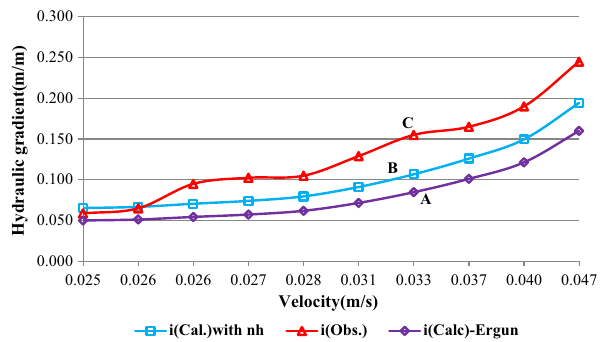
Fig. 10 Comparing plots of hydraulic gradient versus velocity for CGM1 series. Result is after 1200 s of run start. Curve “A” shows variations of ( i ) versus ( V ) based on common porosity concept, curve “B” shows variations of ( i ) versus ( V ) based on hydraulic porosity concept, curve “C” shows variations of ( i ) versus ( V ) based on actual model observations